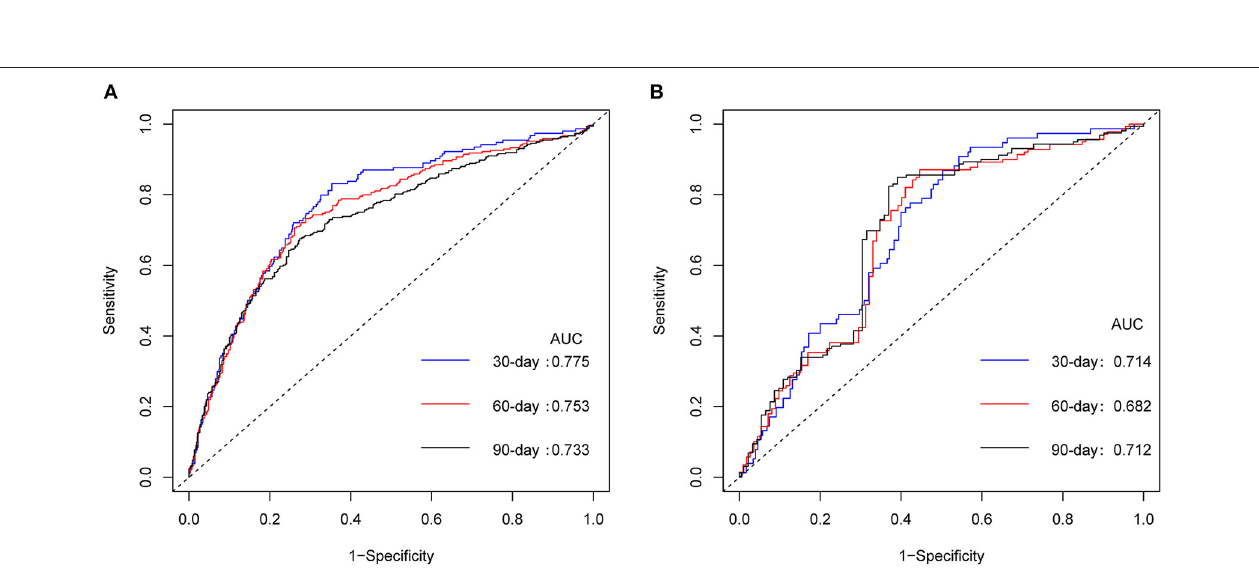
FIGURE 2 | ROC curves for nomogram. ROC curves of nomogram in derivation cohort (A) and in temporal validation cohort (B) . ROC, receiver operating characteristic; AUC, area under the curve.